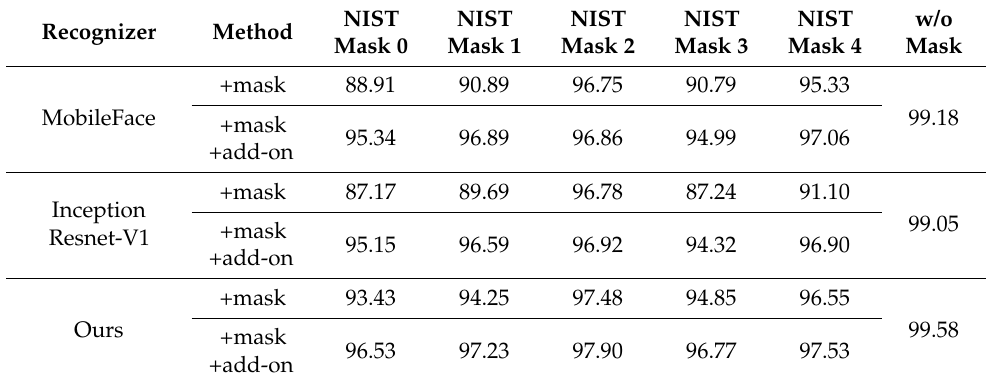
Table 1. Performance comparison results of the proposed method.